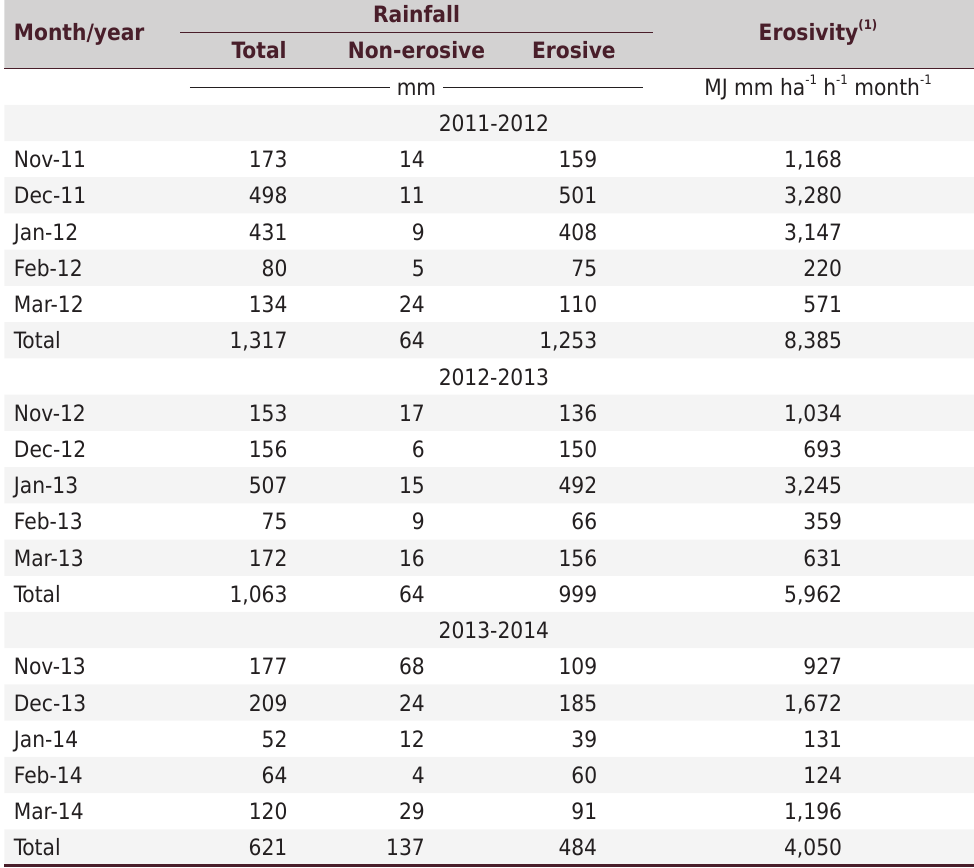
Table 3. Total monthly precipitation, non-erosive and erosive rains, and rain erosivity values during three crop seasons from November to March of 2011 to 2012, 2012 to 2013, and 2013 to 2014 in Lavras, MG,